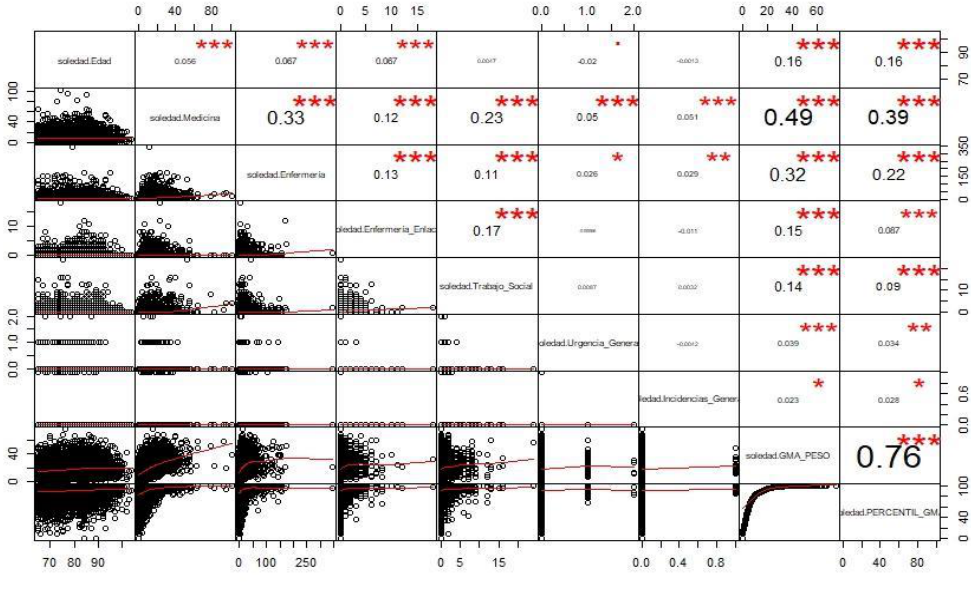
Figure 1. Correlations between all quantitative variables. Basic Health Areas of Gran Canaria. 2018 – 2020. Correlation coefficients and scatter plots.